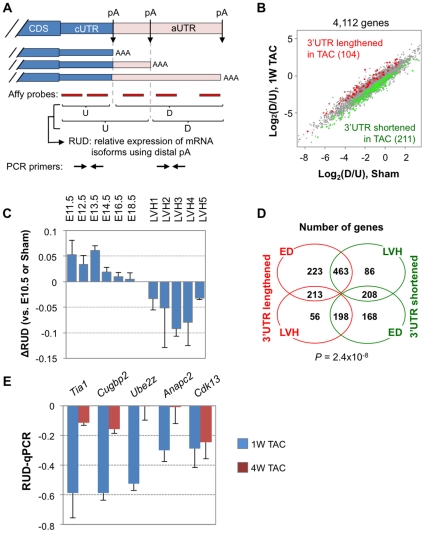
Regulation of 3′UTR isoforms in cardiac hypertrophy and development.(A) Schematic of APA and our method to detect 3′UTR length changes using microarray probes. A hypothetical gene contains three polyA sites, resulting in three 3′UTR isoforms. The 3′UTR regions upstream and downstream of the first polyA site are called constitutive and alternative UTRs, or cUTR and aUTR, respectively. Probes mapped to upstream and downstream of each polyA site were used to calculate the RUD score, which reflects the relative expression of 3′UTR isoforms. The RUD score correlates with 3′UTR length. (B) Comparison of ratio of probe intensity for the downstream region of polyA site to that of upstream region (D/U) of polyA site between Sham and 1 W TAC (LVH3). A total of 4,112 genes were examined. Genes with significant regulation of 3′UTR length (P<0.1, T-test) are colored, with red for genes with 3′UTR lengthened in 1 W TAC and green for those with 3′UTR shortened. (C) Global RUD changes in cardiac development and hypertrophy. The median RUD of all genes in each sample was plotted to represent RUD of the sample. All embryonic samples were compared to E10.5, and TAC samples were compared to Sham. Error bars are standard error of the mean (SEM) based on multiple samples. (D) Venn diagram showing numbers of genes with UTR lengthened or shortened in development and hypertrophy. We selected genes with consistent regulation in at least 4 out of 6 ED samples and in at least 2 out of 3 LVH samples. Fisher's exact test was used to assess significance of the overlap between development and hypertrophy. (E) qRT-PCR analysis of genes with shortened 3′UTRs in TAC. Two sets of PCR primers were designed to target regions upstream and downstream of the first polyA site as shown in (A). The difference in their ratio was used to indicate 3′UTR length changes. PCR primer sequences are listed in Table S2, and gene structures are shown in Figure S6.